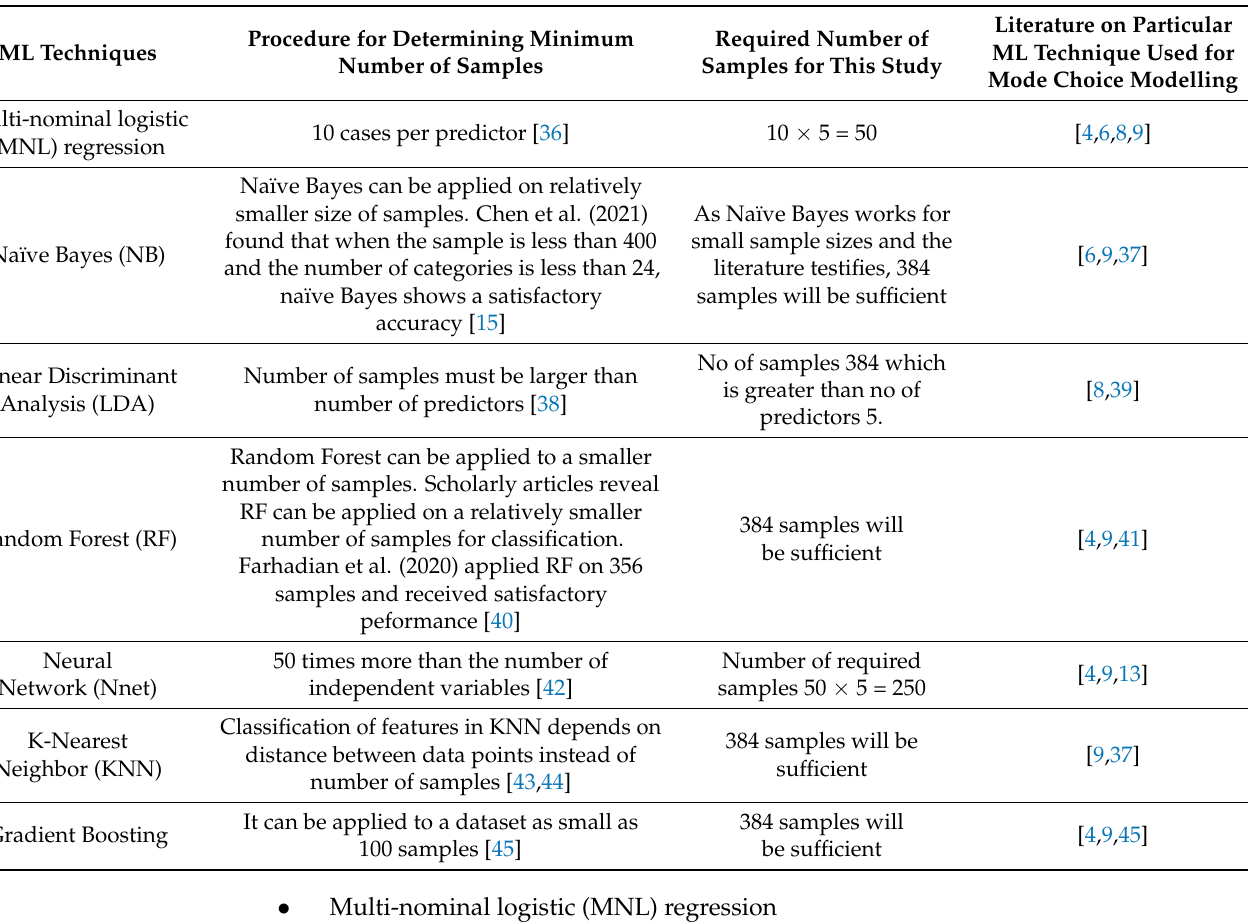
Table 2. Minimum sample requirement for different ML methods and their application in mode choice